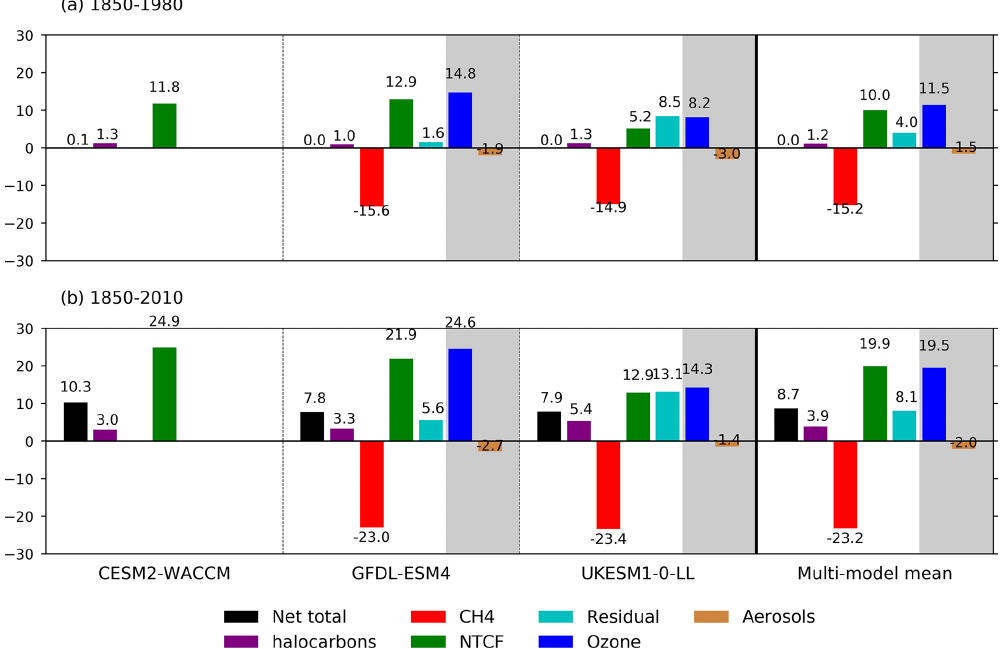
Figure 6. Summary of drivers of OH changes (%) relative to 1850 for the three models and their multi-model mean over (a) 1850–1980 and (b) 1850–2010. We have used decadal means: 1850 refers to 1850–1859, 1980 is 1975–1984, and 2010 is 2005–2014. The shaded areas show the split of the NTCF signal (green) into ozone precursors (blue) and aerosols (brown) when models have performed both the histSST- piNTCF and histSST-piO3 experiments. The residual values (pale blue) are the differences between the total change (black, from the histSST simulations) and the sum of the changes from CH 4 (red), NTCF, and halocarbons (purple). We interpret the residual terms as being due to climate change, in addition to any non-linear interactions between forcings.